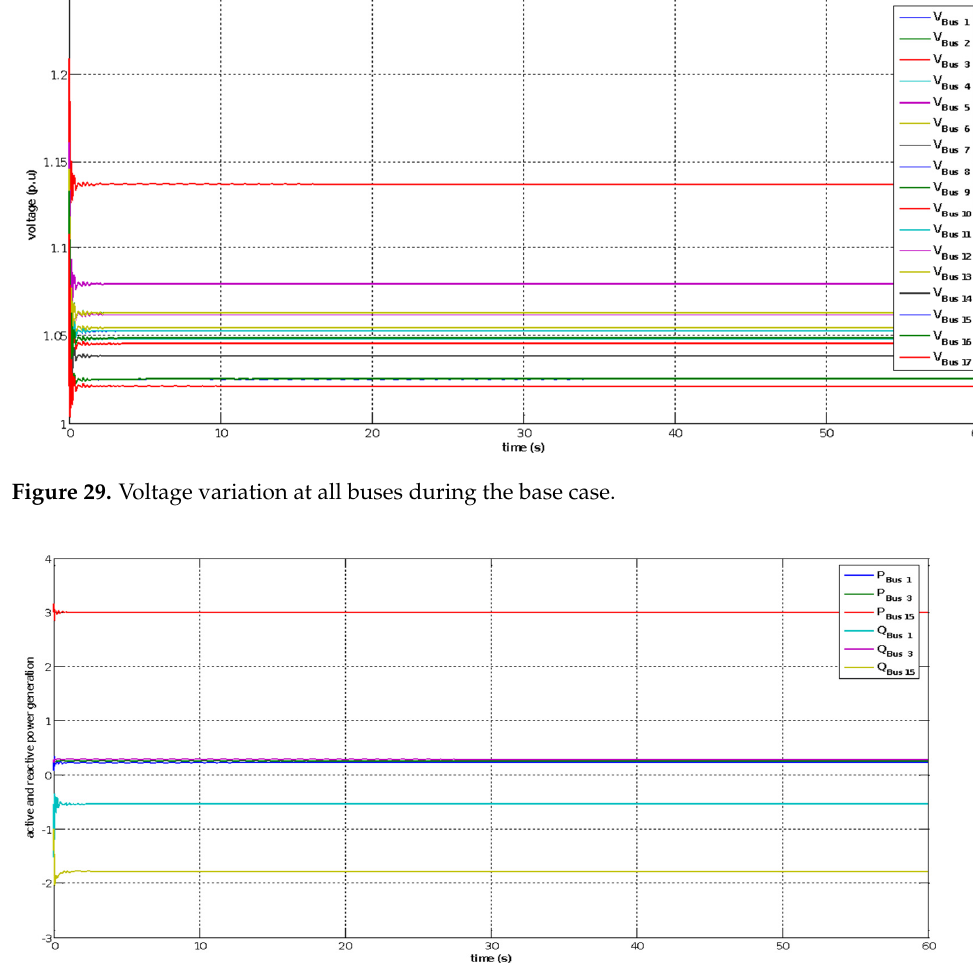
Figure 30. Generated active and reactive power at buses 1, 3, and 15 during the base case.